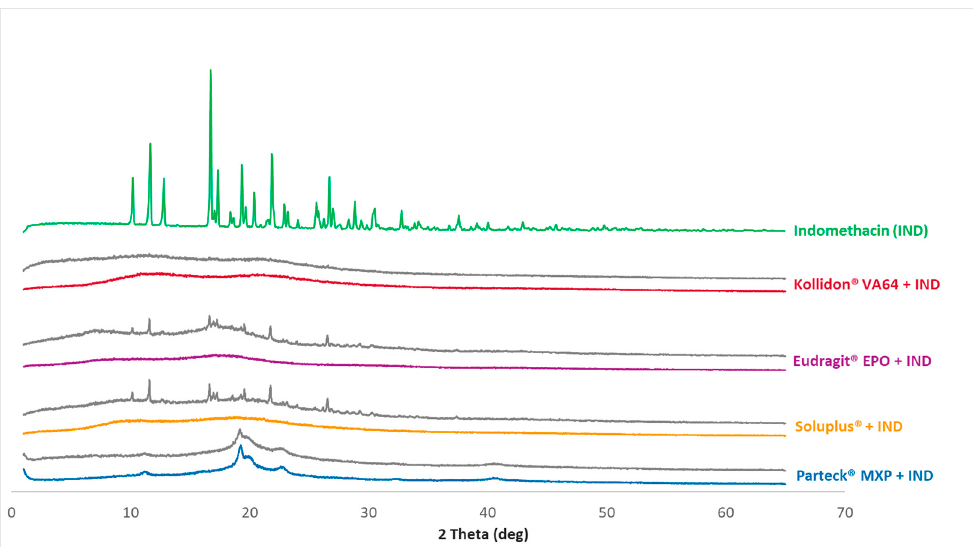
Figure 5. PXRD measurements: The curves for the formulations are clustered. In front of each cluster are the VCM-processed samples with a color code used throughout the data; and in the back are the cryo-milled physical mixtures for each polymer and indomethacin depicted in gray. A pure indomethacin diffractogram for reference purpose is given in the back as a single curve.